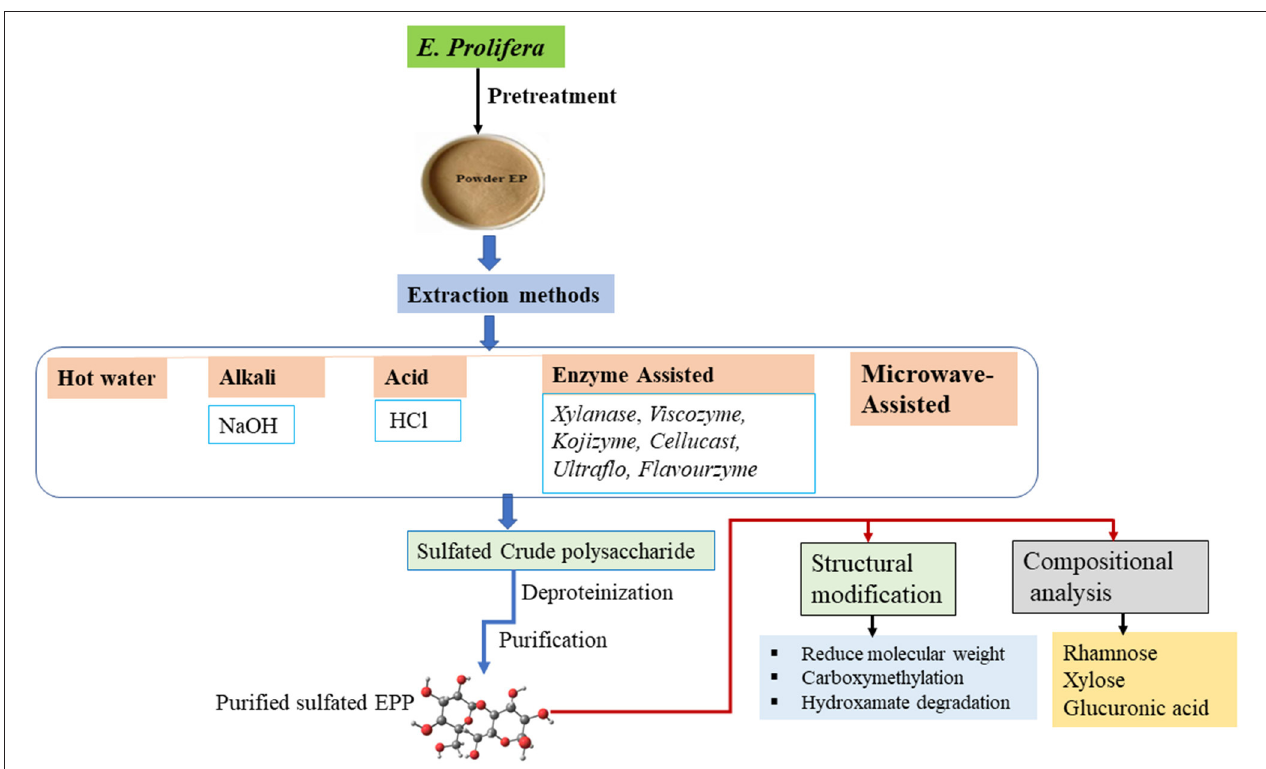
FIGURE 1 | Schematic diagram of the extraction, purification, and modification of Enteromorpha prolifera polysaccharide (EPP).